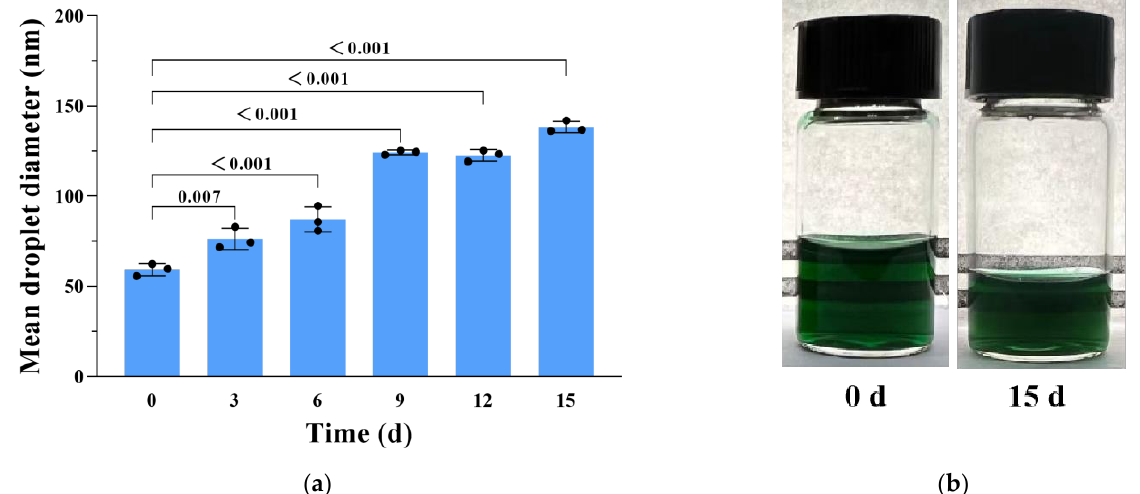
Figure 6. ( a ) The change in droplet diameter of CCIPNs during storage at 4 °C for 15 days. ( b ) The appearance of CCIPNs preserved at 4 ◦ C and stored for 0 or 15 days. Values are expressed as mean ± SD ( n = 3). Each dot represents an independent experiment. The p values vs. indicated groups are presented.